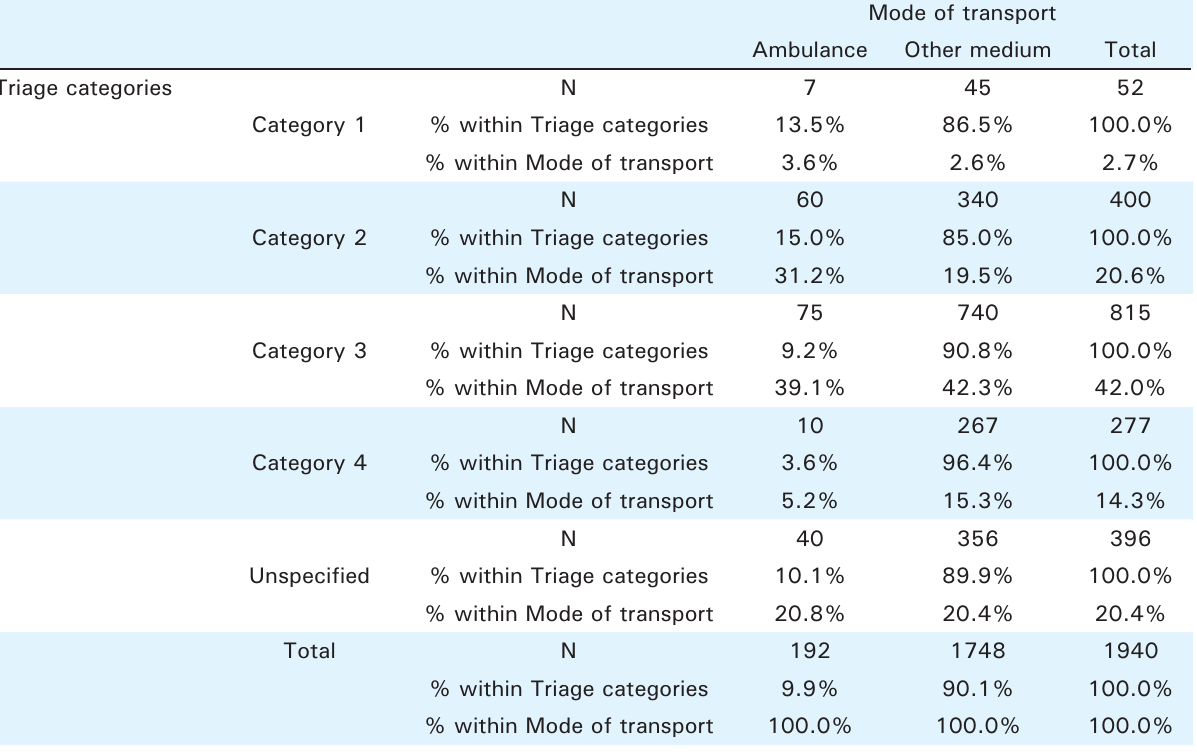
Table 5. PH ED patients by mode of transport and arrival time